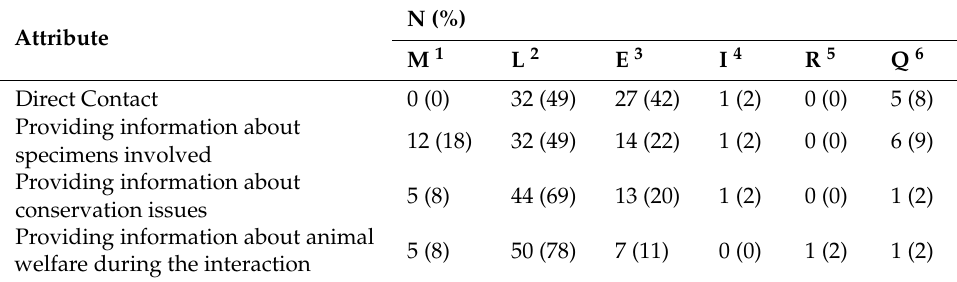
Table 5. Characterization of attributes based on the Kano